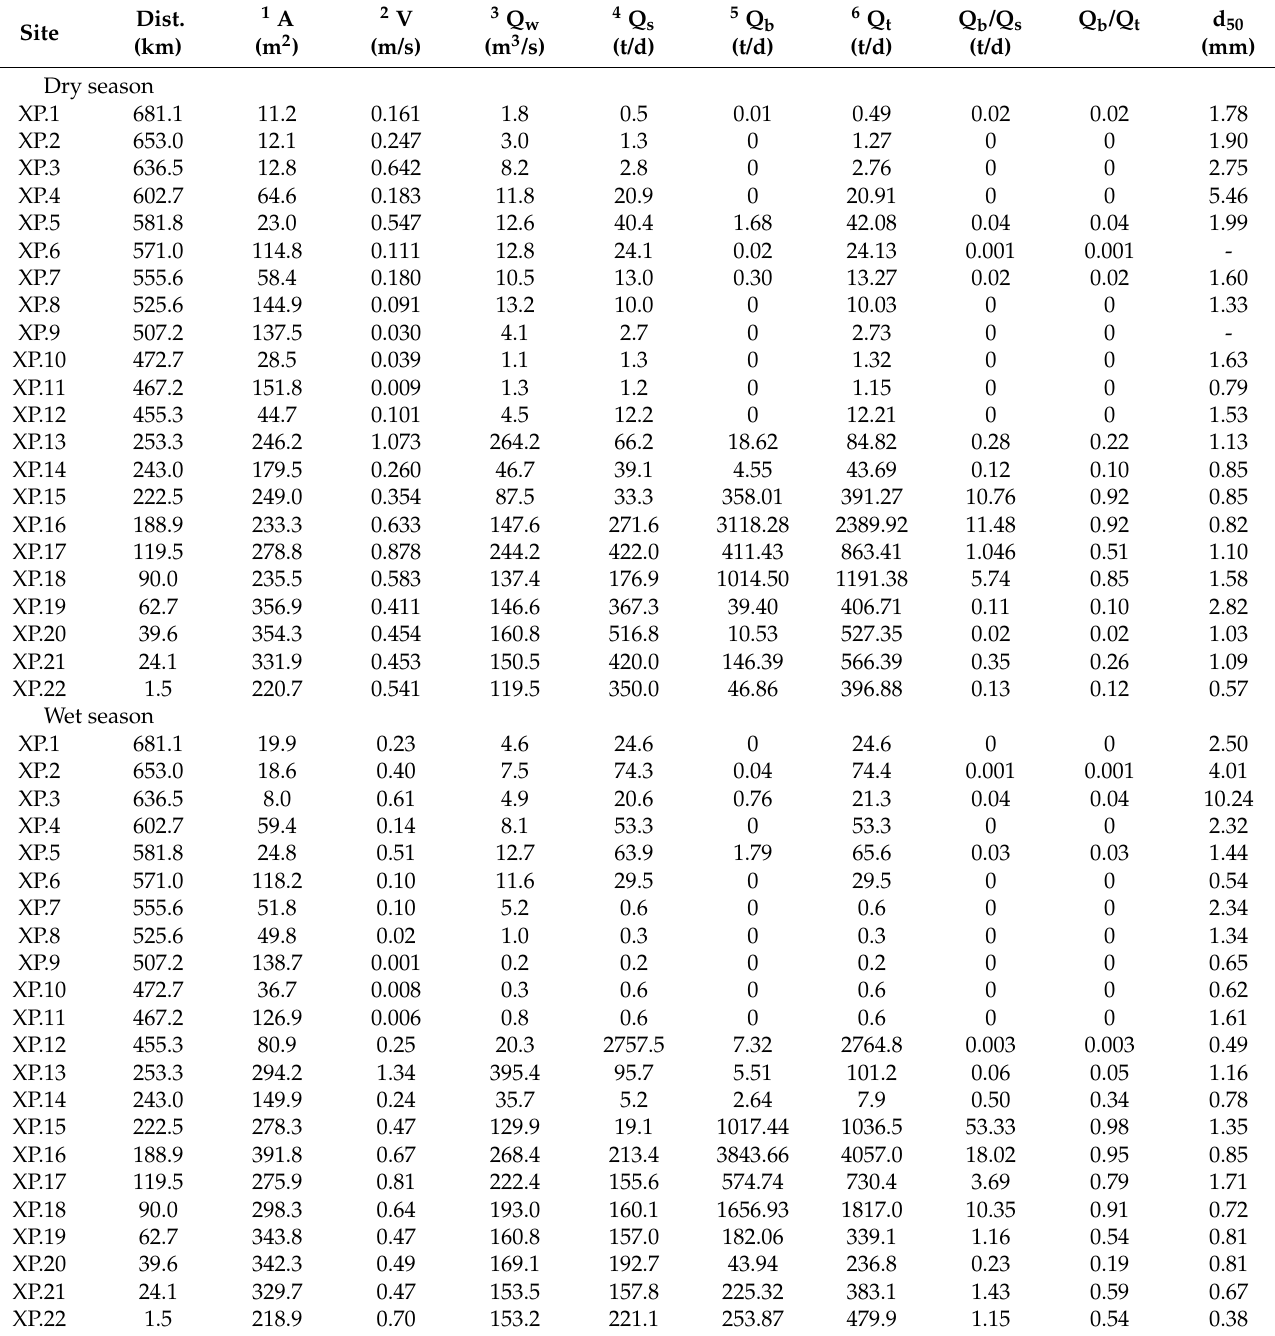
Table 2. Observed streamflow and sediment data along the Ping River during